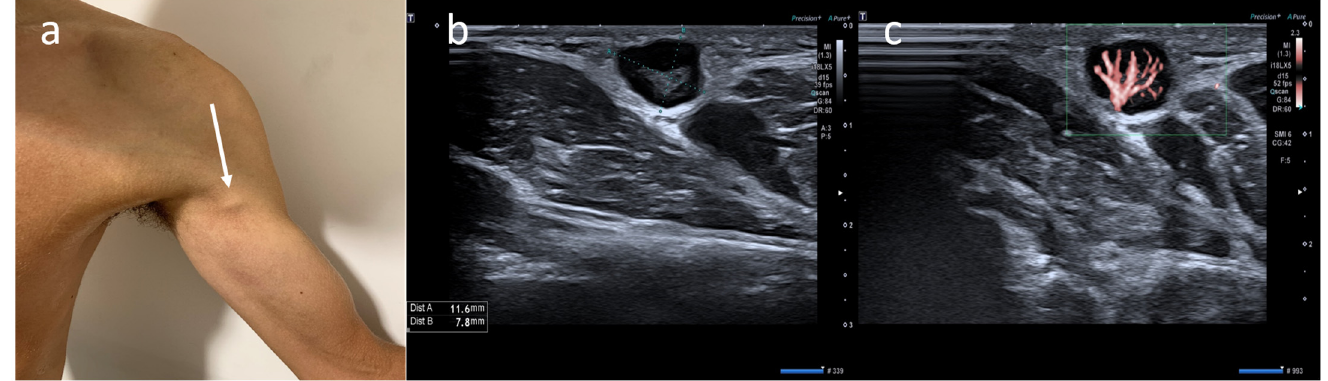
Figure 2. ( a ) A 21-year-old male with unilateral left arm adenopathy (white arrow) noted four days after receiving the first dose of the Moderna COVID-19 vaccine in his left deltoid muscle. ( b ) B-mode sonogram image shows ovalar lymph node with asymmetric cortex and dislocate hilum. ( c ) SMI image shows central and peripheral vascularization.